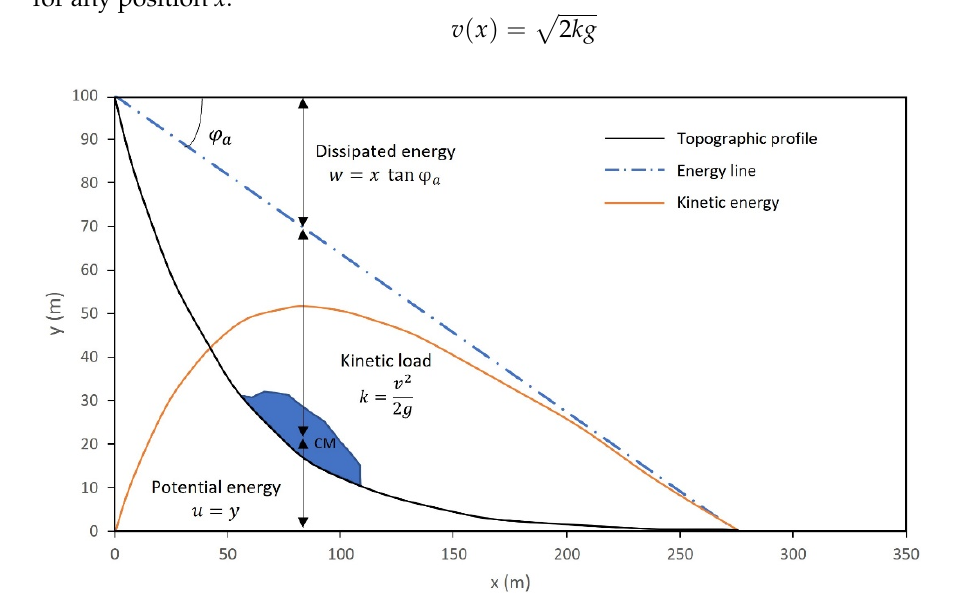
Figure 3. Slide model of a landslide; CM = centre of mass of the displaced body; u = potential energy; k = kinetic load; w = work of the friction forces; φ a = apparent angle of friction (tan φ a = (1-r u )tan φ ’, where r u represents the ratio of water pressure to total vertical lithostatic pressure) (modified from Canuti and Casagli